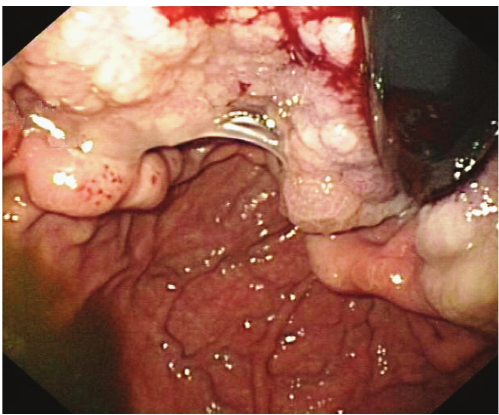
Figure 1: Upper GI endoscopy showing large area of nodular gastric mucosa, extending from GE junction to surrounding body.